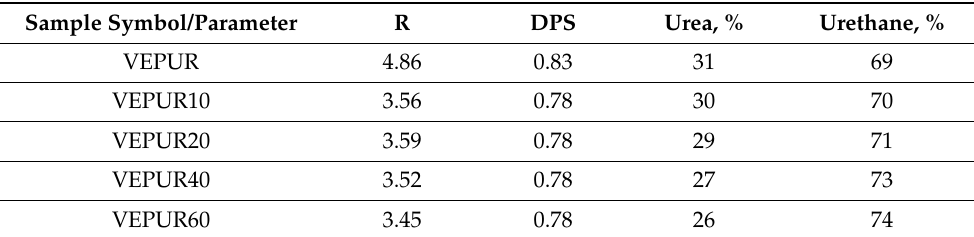
Figure 11. The range of the band of carbonyl groups in the analyzed materials calibrated with the vibrations of the C=C group in the aromatic ring (1600 cm −1 ). vibrations of the C=C group in the aromatic ring (1600 cm − 1 ). Table 7. Results of multiplet band analysis for vibration of carbonyl groups. Table 7. Results of multiplet band analysis for vibration of carbonyl